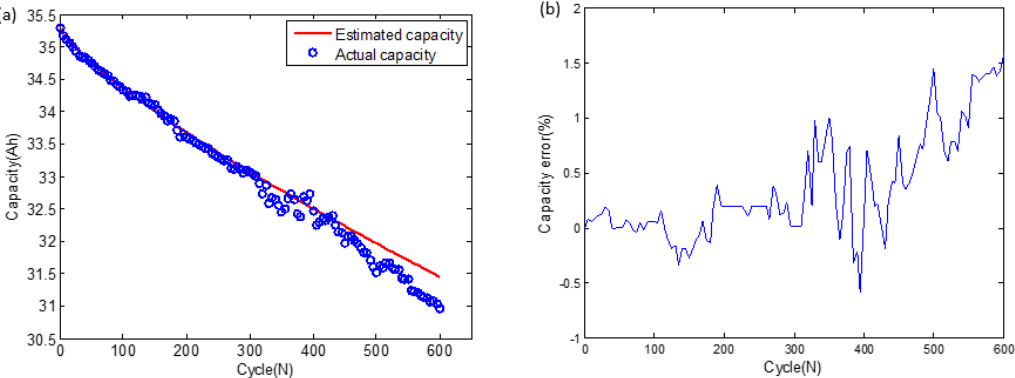
Figure 10. The battery capacity prediction result: ( a ) capacity prediction; ( b ) error of capacity prediction.